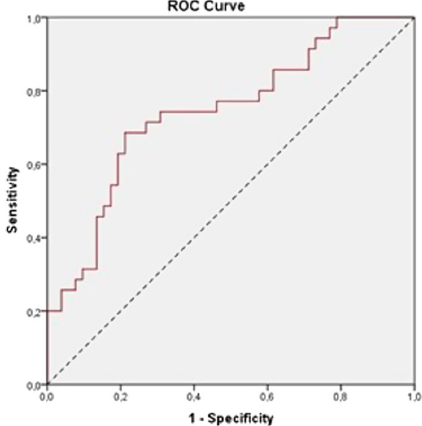
Figure 2. Receiver operating characteristic analysis graphic of progranulin.